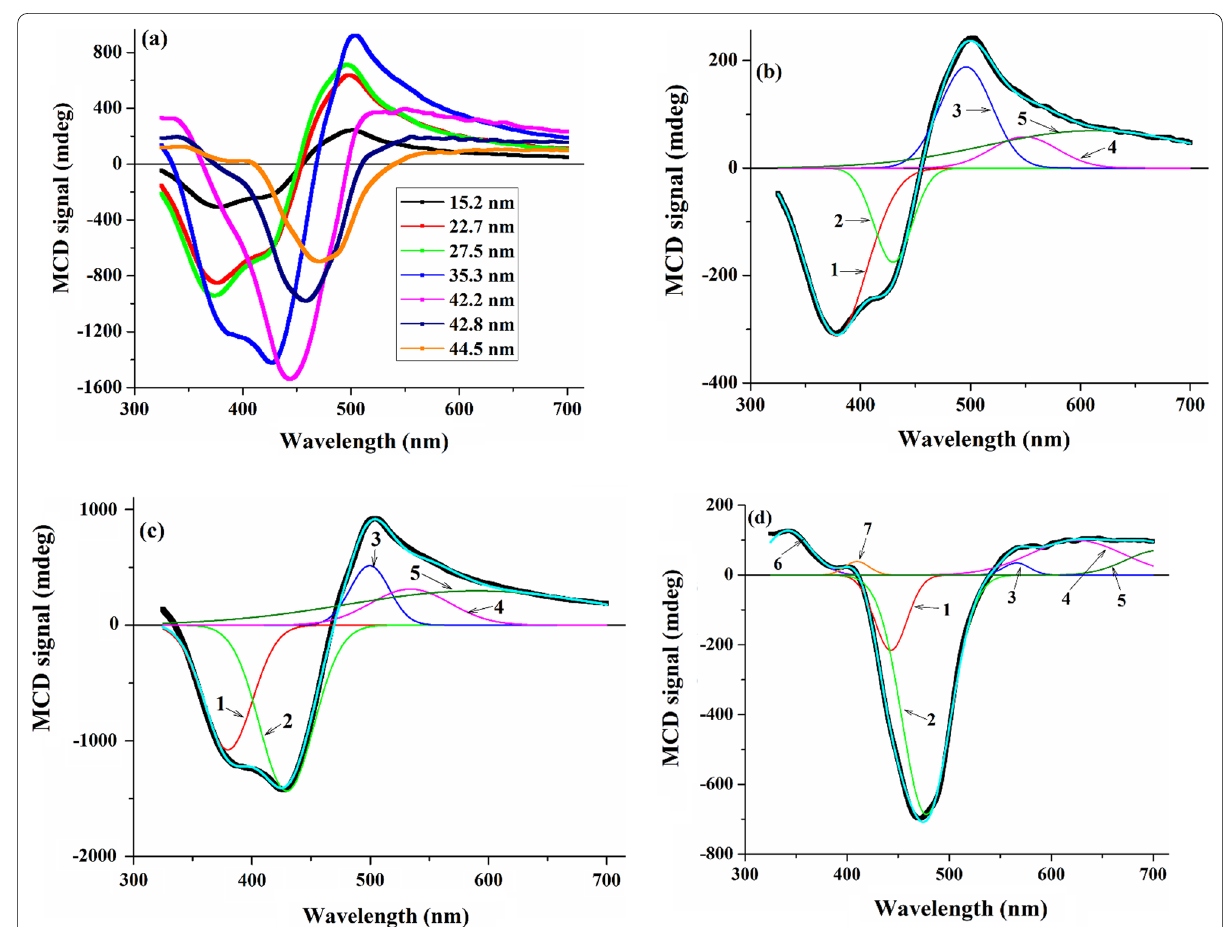
Fig. 4 a MCD spectra of the Bi‑doped YIG nanopowder and the best Gaussian fitting for the samples with b D